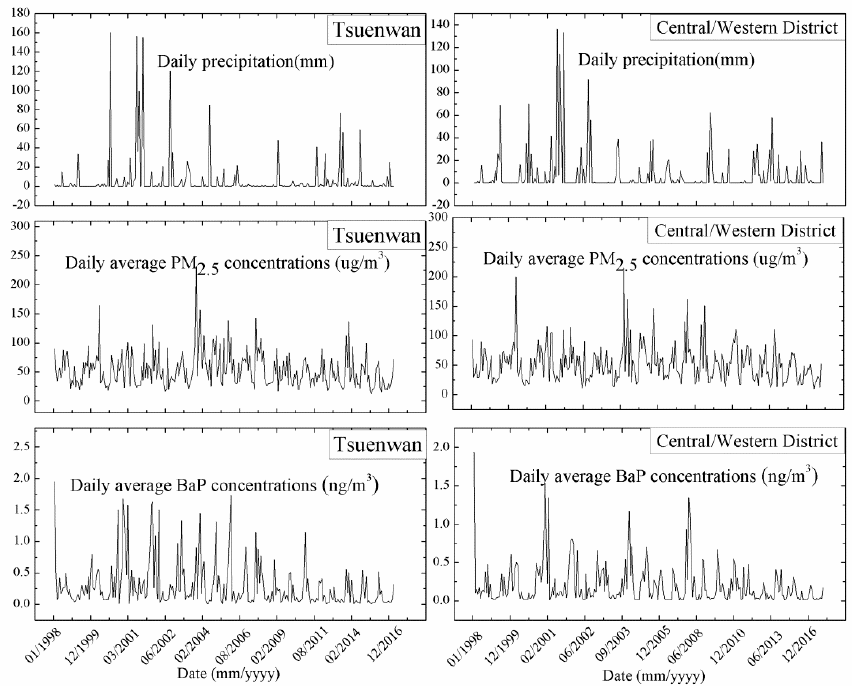
Figure 1. The regular monitoring data from January 1998 to December 2016.